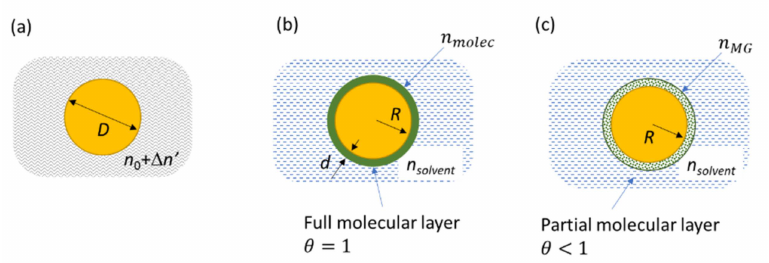
Figure 6. ( a ) A spherical nanoparticle of diameter D in a medium of index n 0 + ∆ n (cid:48) ( b ) nanoparticle functionalized by a molecular layer of thickness d , in a medium of index n solvent , ( c ) the same nanoparticle with a partial coverage θ < 1. The refractive index of this partial monolayer n MG is calculated with the Maxwell–Garnett